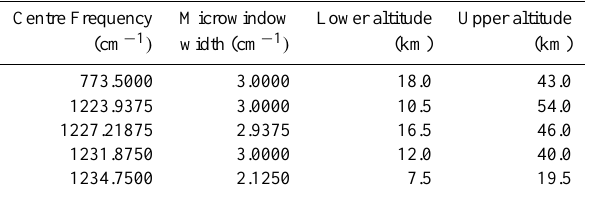
Table 3. Microwindows for the MIPAS carbonyl fluoride retrieval. Centre Frequency